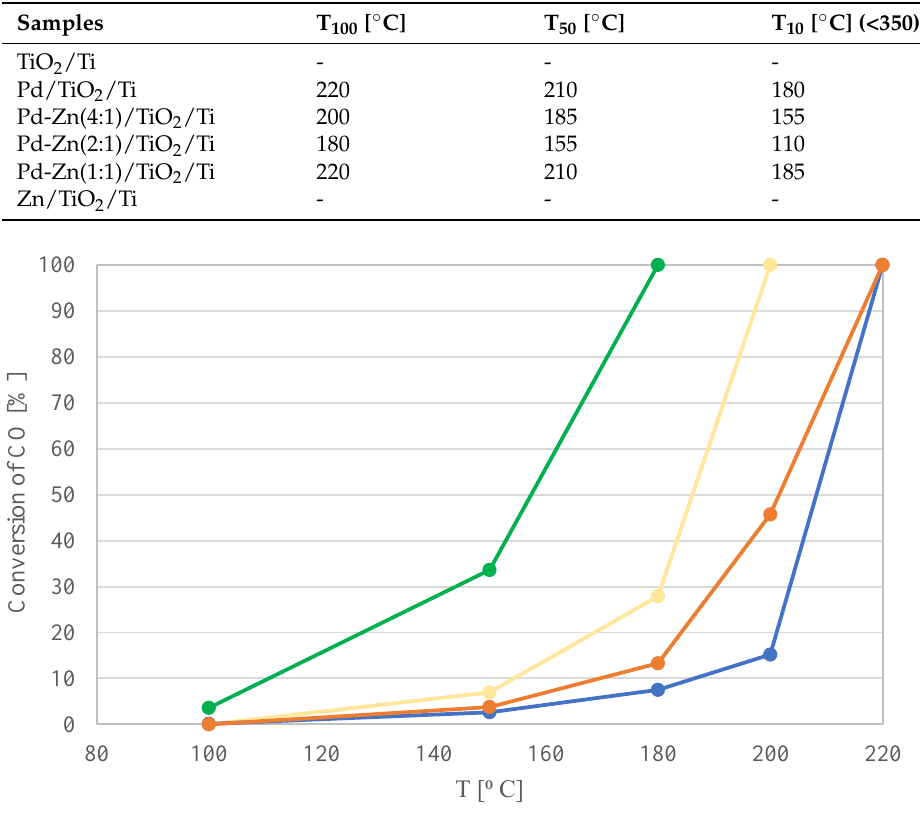
Table 1. T 100 , T 50 , and T 10 for different wire catalysts.